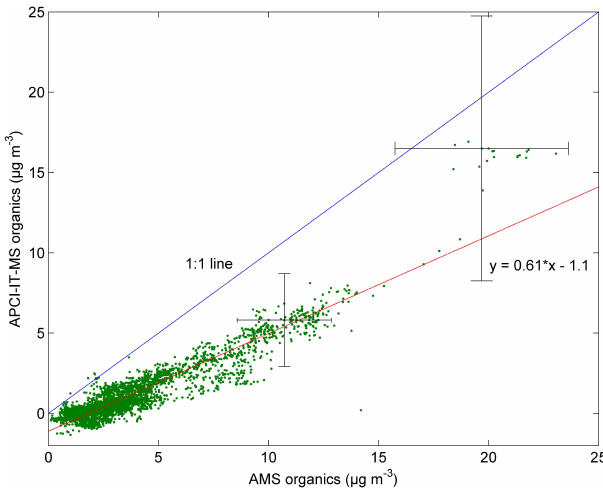
Fig. 5. Correlation plot of organic signals from mVACES/APCI- IT-MS and C-ToF-AMS during the HUMPPA-COPEC 2010 field campaign (APCI-IT-MS signal (sum m/z 150–500) based on instru- ments response to pinic acid). Estimated errorbars for AMS uncer- tainty are ± 20% and for APCI-IT-MS uncertainty are ±